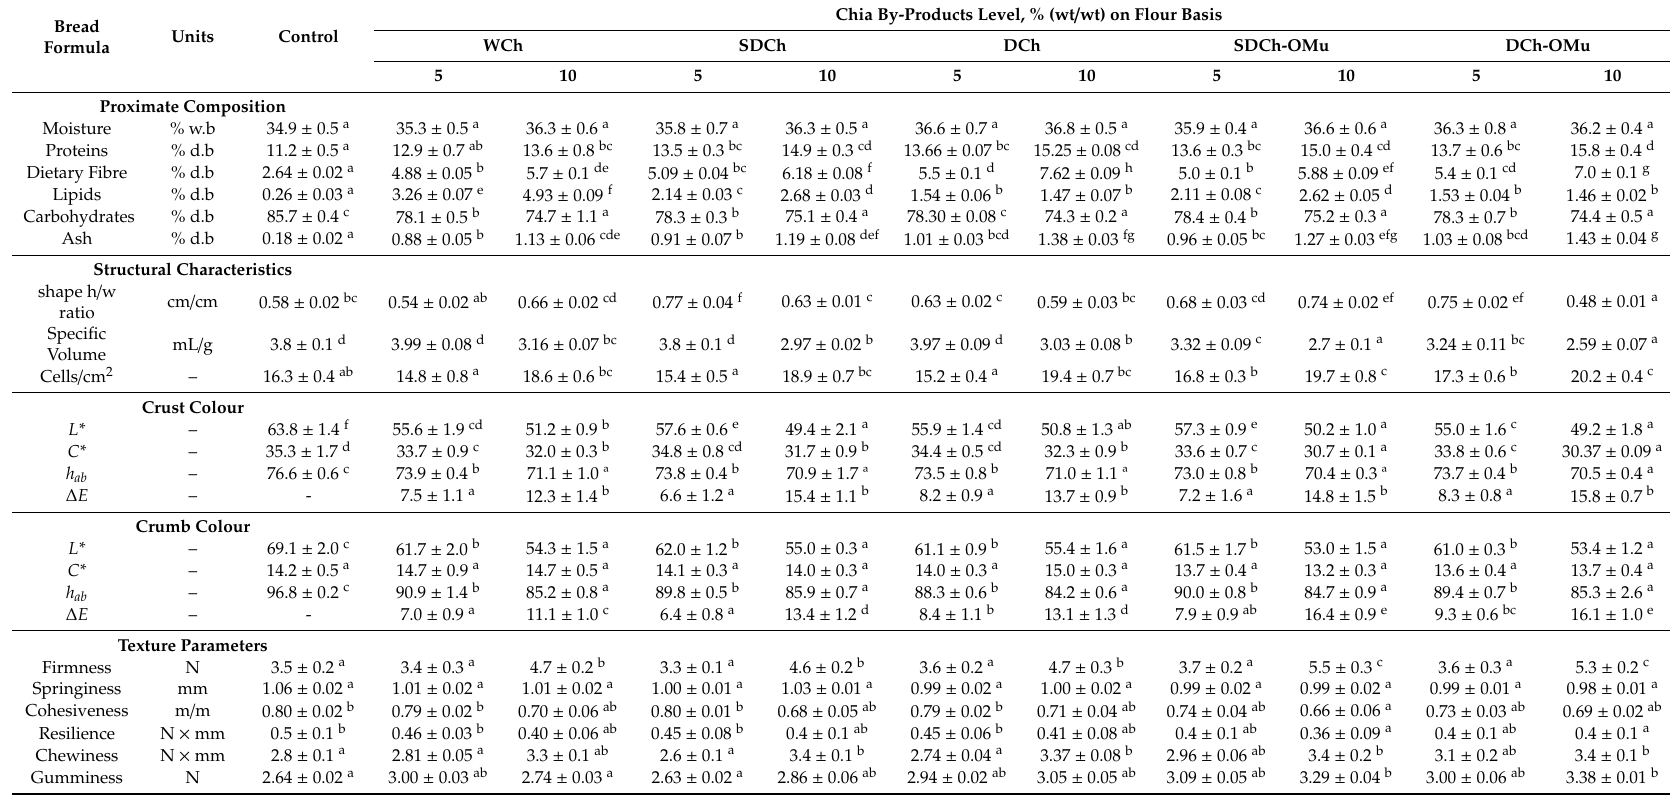
Table 2. Physico-chemical characteristics of fresh bread with chia